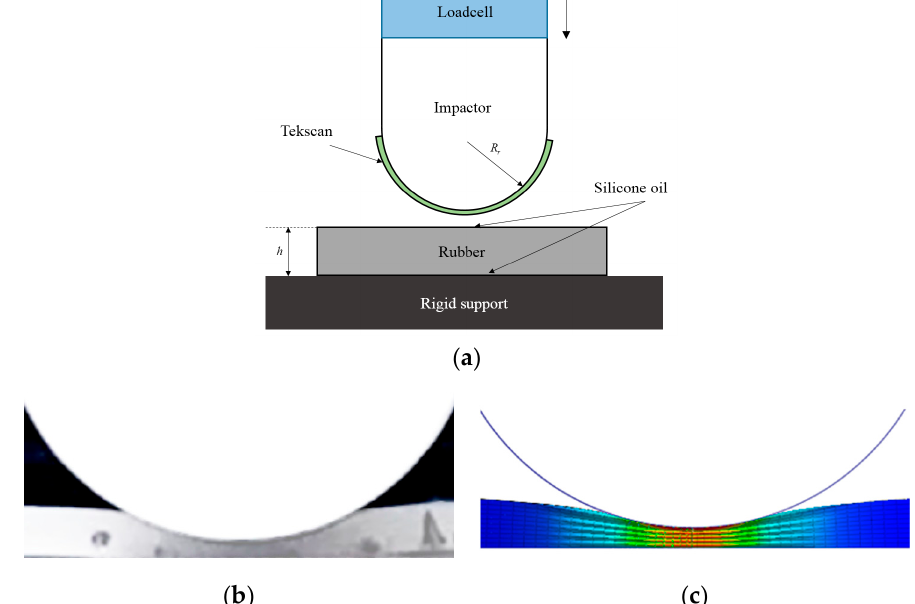
Figure 3. Indentation of silicone rubber: experimental test configuration ( a ), experiment ( b ), FE simulation ( c ).